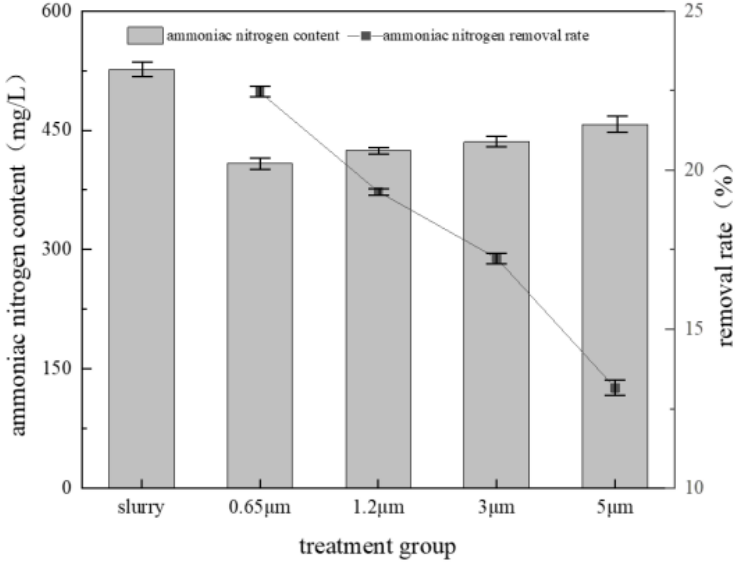
Figure 3. Effects of the microfilter membrane system on ammonia nitrogen.